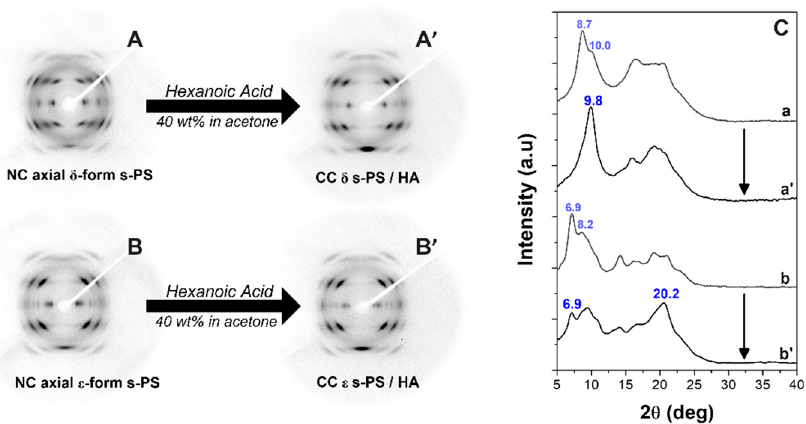
Figure 5. WAXD patterns of axially stretched s-PS films exhibiting the NC δ form before ( A ) and after HA sorption ( A’ ) and the NC ε form before ( B ) and after HA sorption ( B’ ). The equatorial profiles of these 2D patterns are shown in (C) (a, a’, b, b’).